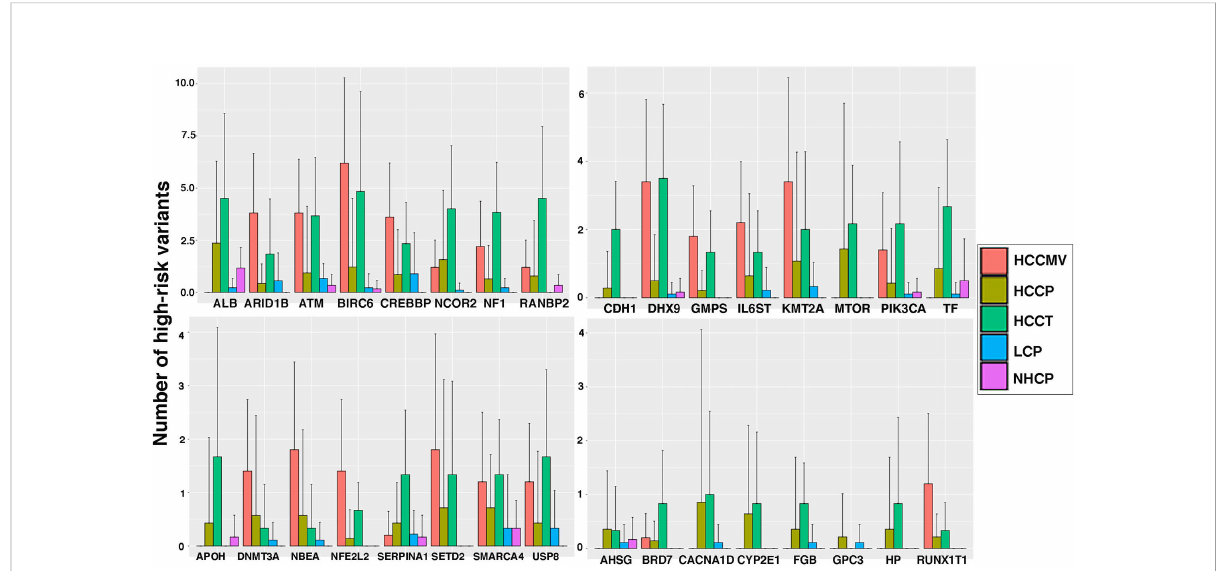
Figure 4. Focusing on certain selective tissue speci fi c transcripts with speci fi city and sensitivity to identify high-risk